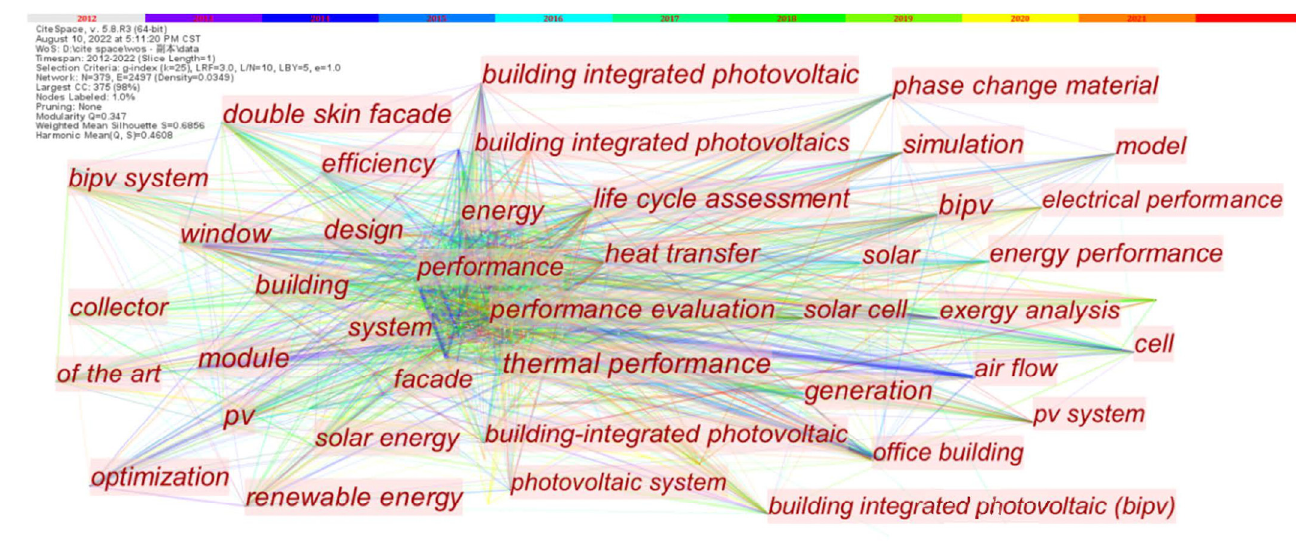
Figure 5. Keyword co-occurrence.